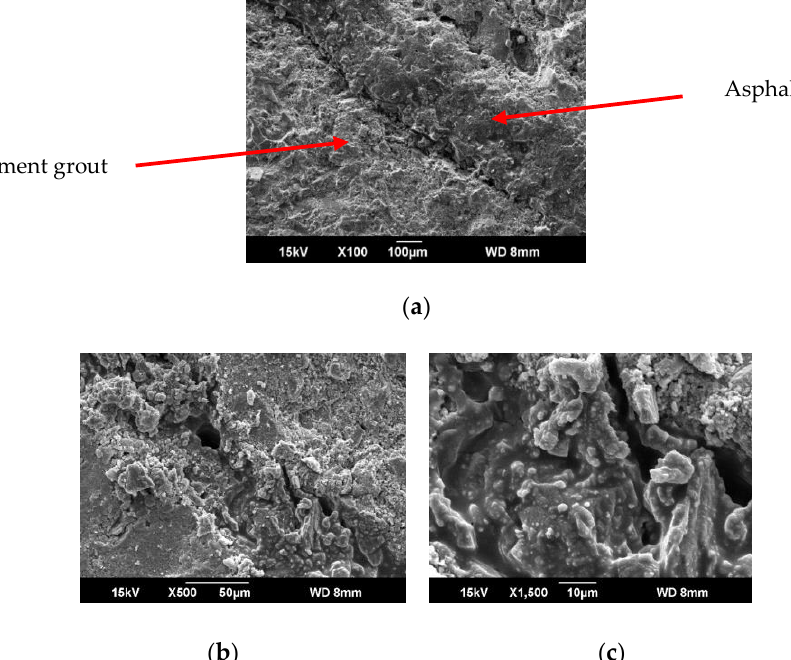
Figure 3. Microstructure of cement-asphalt interface modified by silane coupling agent with different sizes: ( a )100 μ m;( b ) 50 μ m; ( c ) 10 μ m.